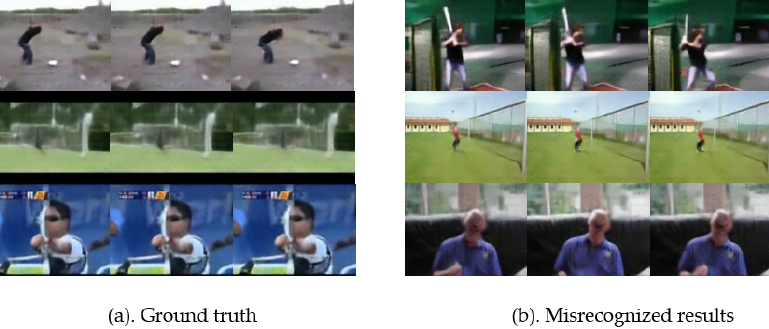
Figure 9. Snapshots of parts of misrecognized activities. ( a ) is the ground truth label, and ( b ) is the misrecognized